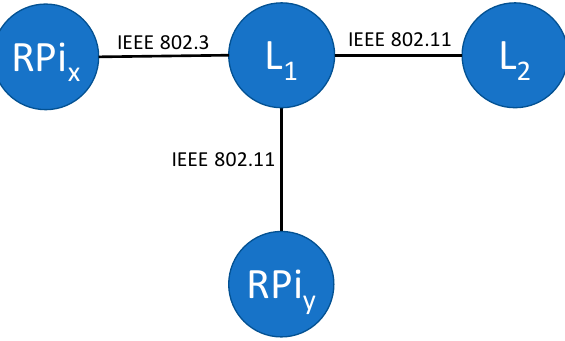
Figure 7. PresenceSensor application testing deployment.